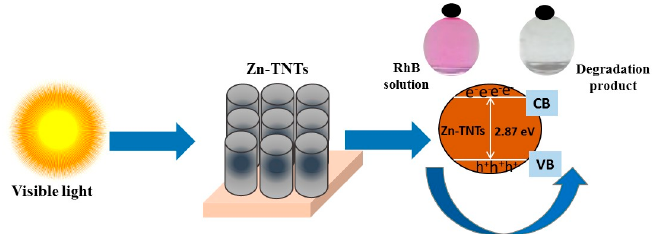
Figure 9. Suggested tentative mechanism for photocatalytic decontamination of RhB over Zn-TNTs.